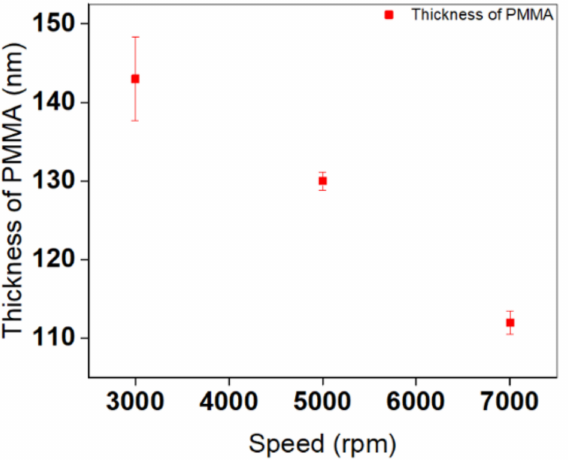
Figure 5. The influence of spin-coating speeds on the thickness of deposited PMMA layers when metal is introduced. Error bars are also displayed in this plot. Measurements of thickness values are extracted using an AFM technique via a line-scratching